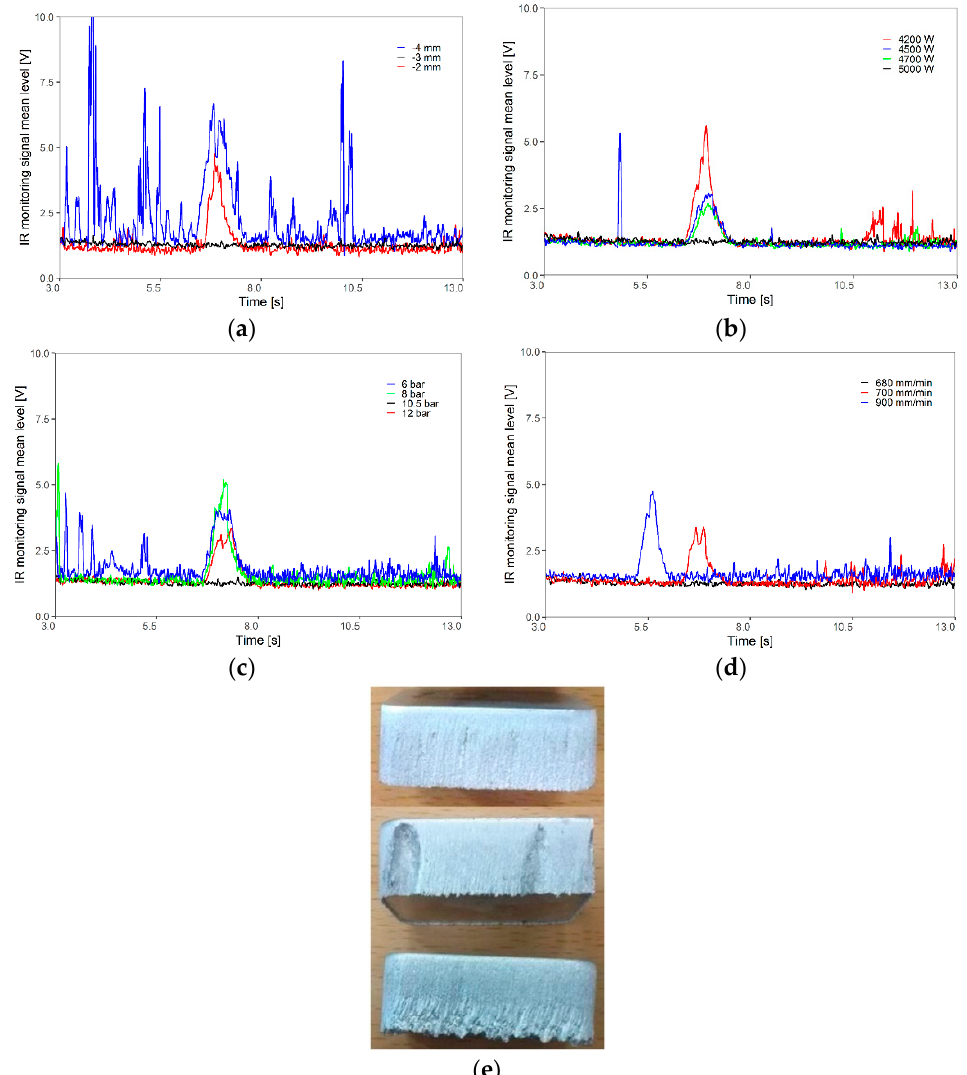
Figure 5. IR monitoring mean levels (gain 2) obtained during the laser cutting of aluminum of 10 mm with oxygen, comparing the ideal cutting conditions (black line) with variations in: ( a ) focal position; ( b ) laser power; ( c ) gas pressure; and ( d ) velocity. ( e ) Optical images of cut samples with the ideal cutting parameters (top), with a focal position of − 2 mm (center) and with a focal position of − 4 mm (bottom).